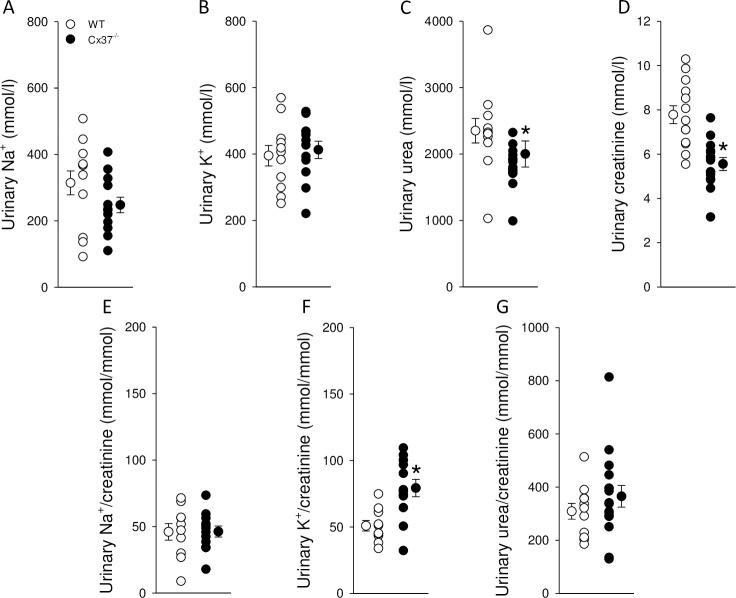
Effects of 18-hour WD on urinary electrolytes and urea in Cx37-/- and WT mice.Urinary concentrations of (A) Na+ and (B) K+ were not significantly different between genotypes after WD. In contrast, concentrations of (C) urea and (D) creatinine were ~15% and ~29% lower in Cx37-/- compared to WT mice, respectively. Urinary Na+/creatinine and urea/creatinine were not different between genotypes (E and G, respectively); however, urinary K+/creatinine was significantly higher in in Cx37-/- compared to WT mice (F). Data are expressed as mean ± SEM; n = 11–16. Data were analyzed by Student’s t-test, *P<0.05 versus WT.